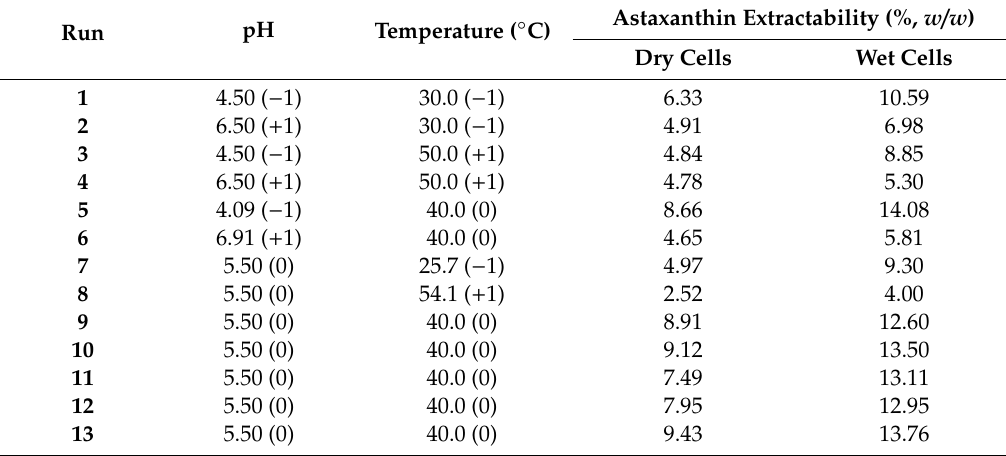
Table 1. E ff ect of pH and temperature on astaxanthin extractability (%, w / w ) of dry and wet samples of X. dendrorhous DSMZ 5627 cells after treatment with Accellerase